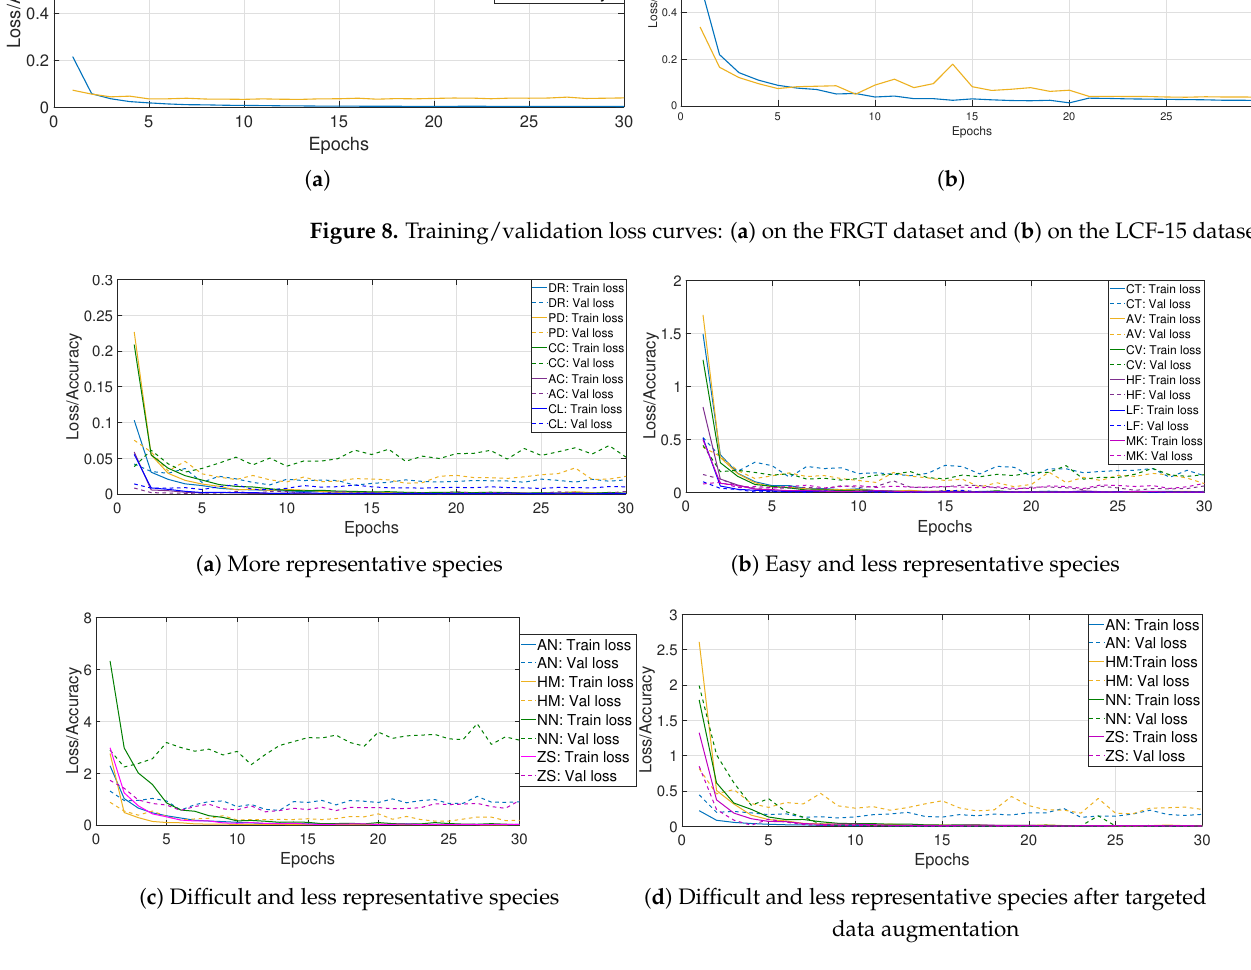
Figure 9. Training/validation loss curves for some species of the FRGT dataset. ( a , b ) show well converged curves for, respectively, species that are most representative and species that are less representative but easy to be recognized. ( c ) shows badly converged curves for species that are less representative and difficult to be recognized with available data. ( d ) illustrates the loss curves of species in ( c ) with targeted data